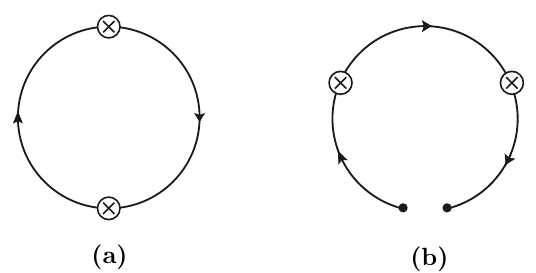
Figure 12. Feynman diagrams of the perturbative contribution (left) and the contribution of the quark condensate (right) to the two-point Green functions.